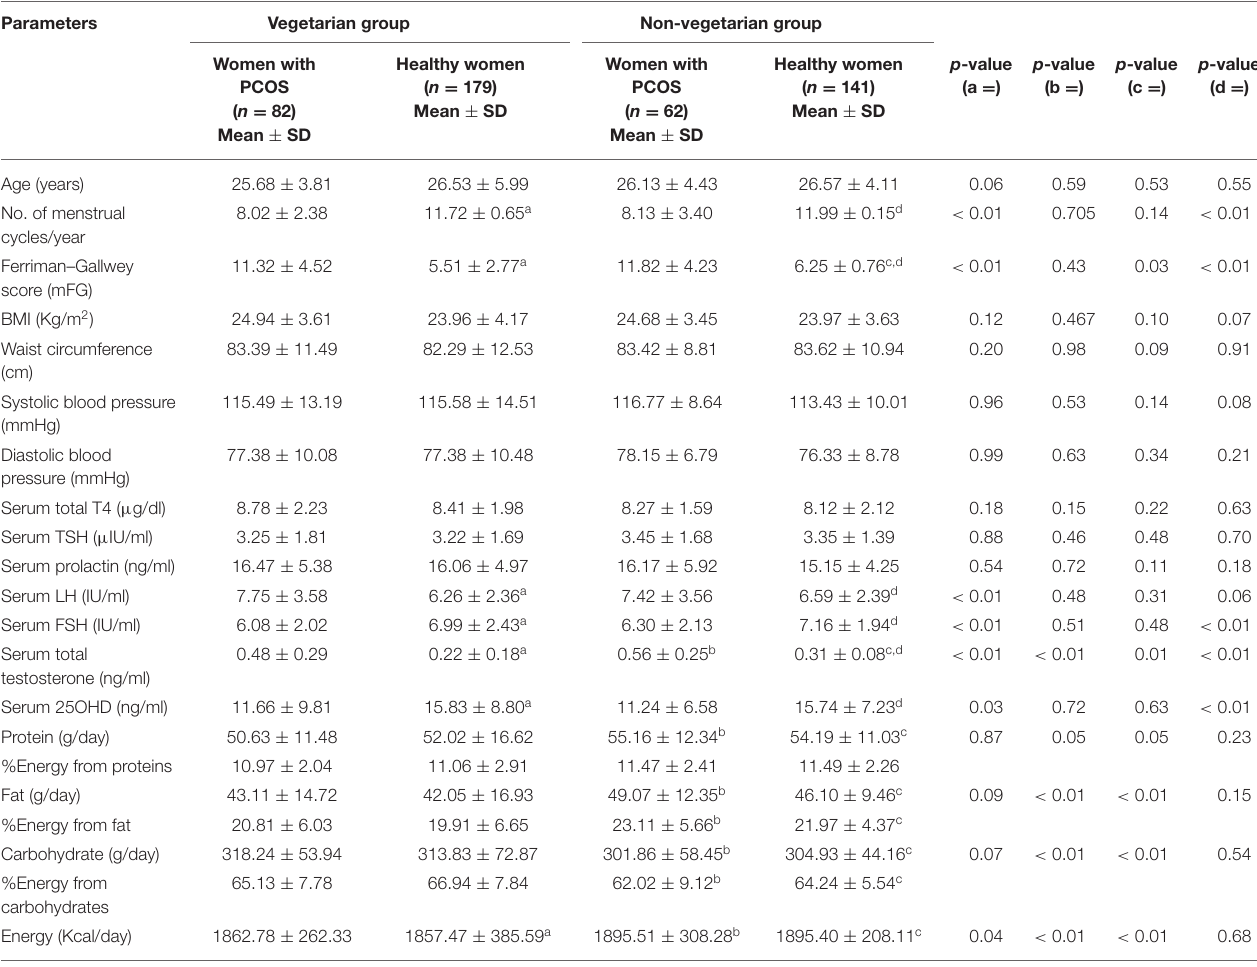
TABLE 1 | Showing comparison of clinical and hormonal parameters among PCOS vs. healthy women from Delhi and Srinagar.